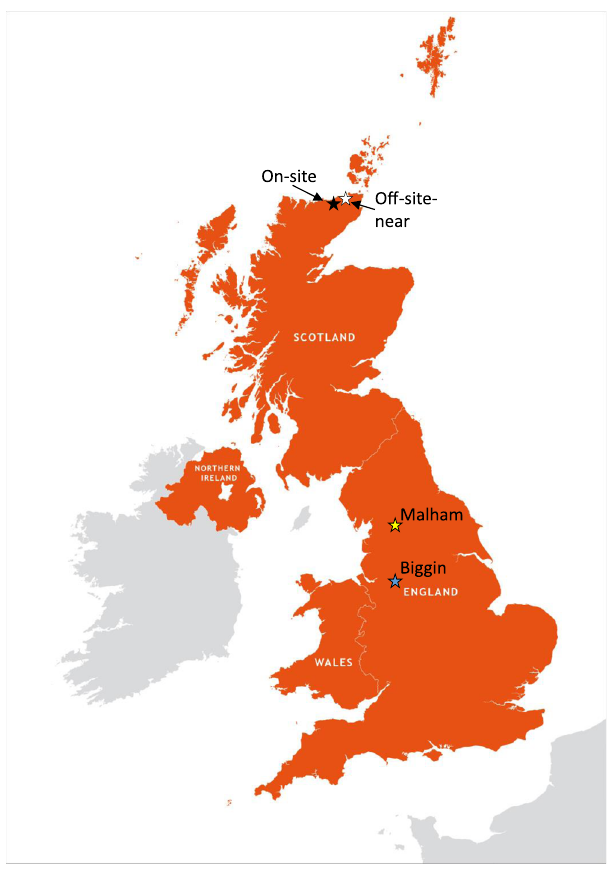
Fig. 1 A map of the United Kingdom with sample locations. On-site samples are denoted with a black star; off-site-near: white star; Malham: yellow star; Biggin: blue star. Base map ©